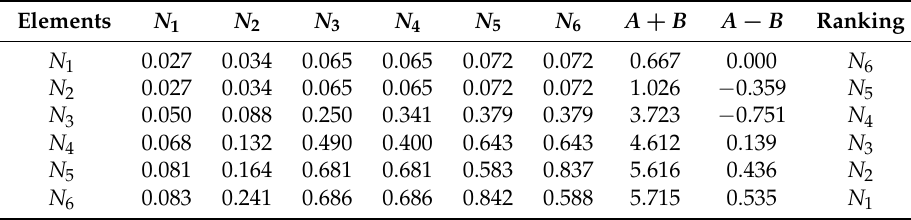
Table 4. Total relation matrix (TRM) and final